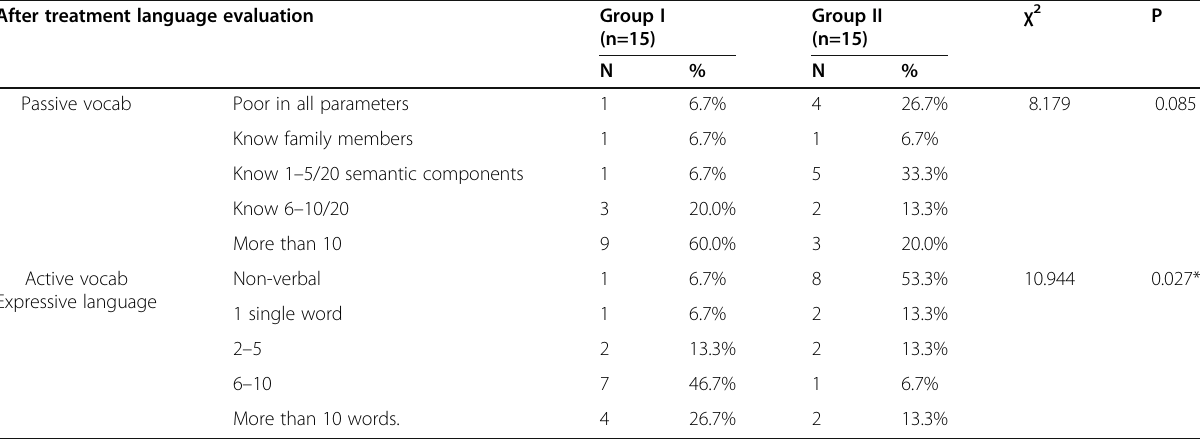
Table 4 After treatment language